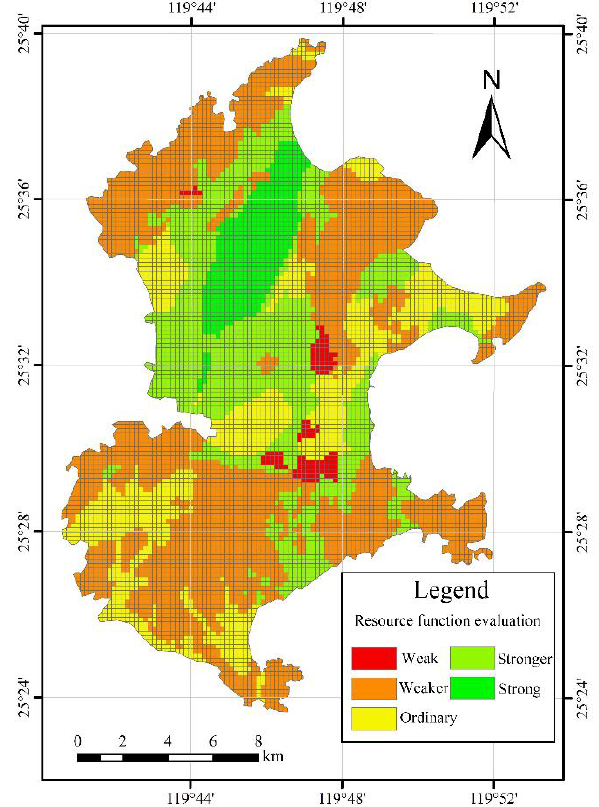
Figure 5. Evaluation results of groundwater resources function in the study area.